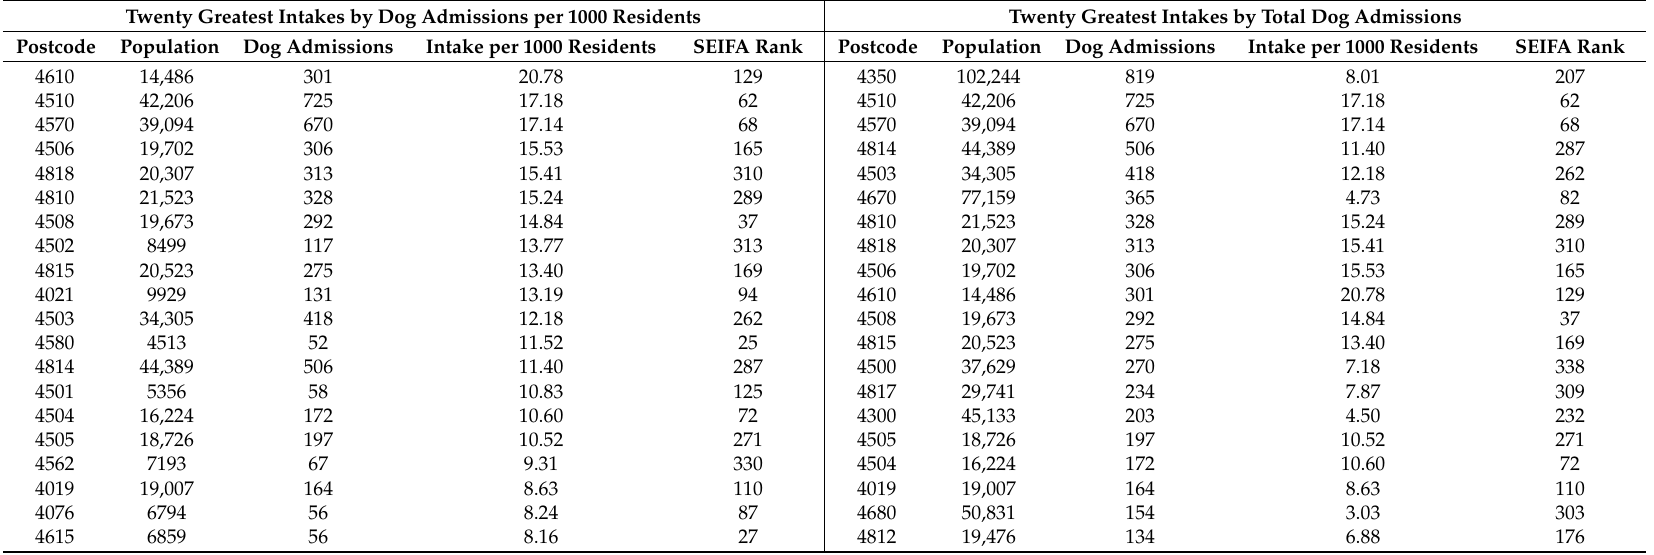
Table 3. Shelter intake according to source